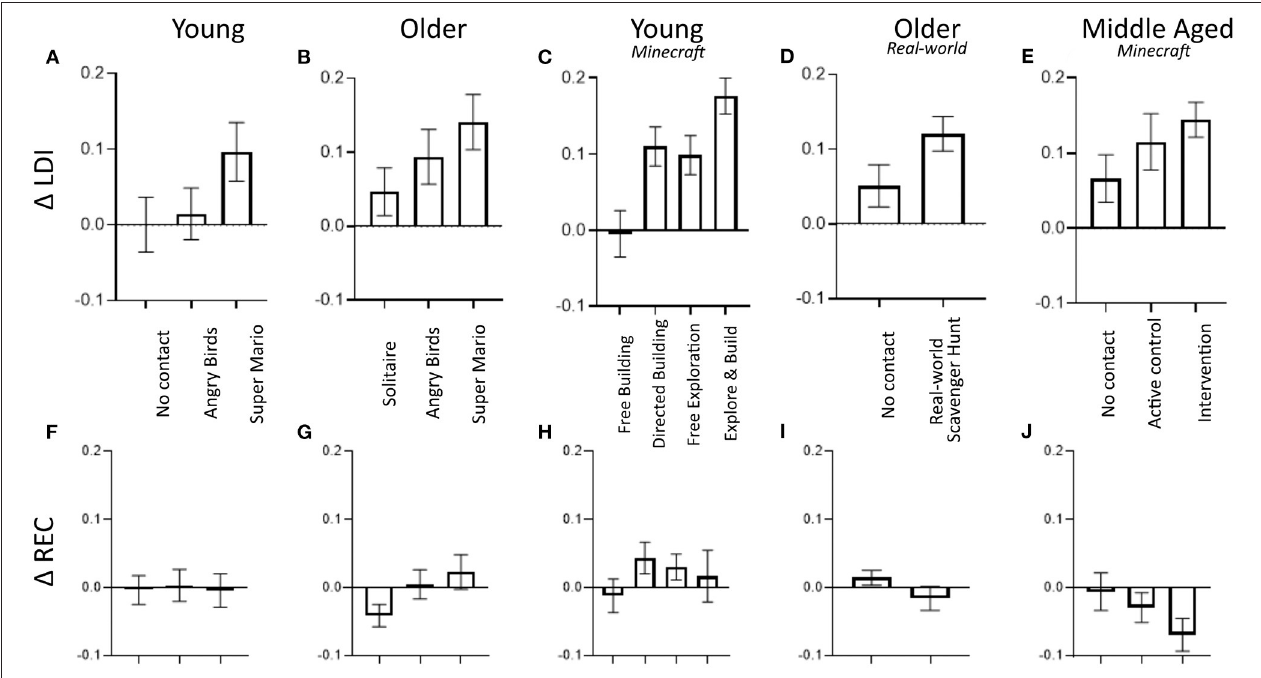
FIGURE 3 | Results from four prior studies and the current study showing a consistent pattern of improvement in LDI scores (top) that tracks the amount of enrichment with no change in REC scores (bottom). Data from: (A,F) Clemenson and Stark (2015), (B,G) Clemenson et al. (2020), (C,H) Clemenson et al. (2019), (D,I) Kolarik et al. (2020), and (E,J) the present study. In each, conditions are ordered left to right in order of presumed level of enrichment or